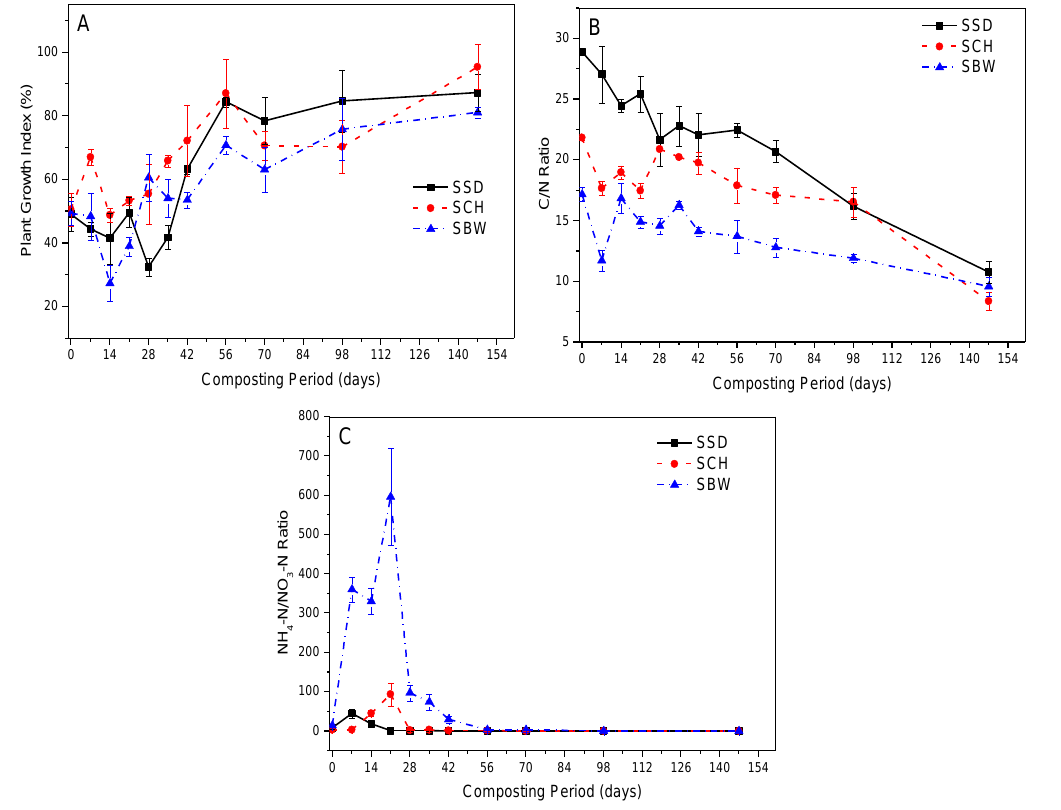
Figure 5. Changes in: ( A ) plant growth index; ( B ) carbon/nitrogen (C/N); and ( C ) ammonium-nitro- gen/nitrate (NH4 + -N/NO 3− -N) during composting of faecal sludge-FS with brewery waste-SBW, cof- fee husks-SCH, and sawdust-SSD. Error bars represent the standard error of n = 2. During the late stages of composting, all the composting piles exhibited a significant increase in the PGI values, which implied that the phytotoxic substance had disappeared, and the compost was generally phytotoxic free and mature. The literature has docu- mented the germination index/ plant growth index as one of the most reliable and sensi- tive indicators for evaluating compost phototoxicity and maturity [68]. PGI threshold value of ≥80% has been suggested for phytotoxic-free and mature compost [69]. In the present study, this threshold value was reached and exceeded after a composting period of 8 weeks by SSD and SCH piles. However, the compost was still immature at this stage since further fluctuations (drops) in PGI values below the threshold value were observed as the composting process progressed, until 14 and 21 weeks, respectively, when they sta- bilised. Similarly, the SBW composting piles reached the threshold value after a compost- ing period of 21 weeks and this implied that the compost was mature. It is very interesting to note that according to this PGI threshold value criterion, the SBW compost reached maturity after 21 weeks composting period, yet the composting temperature and other maturity indices had indicated that the SBW compost had stabilised or matured about 4 weeks earlier. This result suggests that there is no single index that can be used solely for accessing the efficiency of the composting process and compost maturity. However, the delay of the SBW piles in reaching the PGI threshold value can be attributed to the high NH 4+ -N concentrations observed in such piles, which may have inhibited plant growth. The PGI results also suggest that the bulking agent types had a significant effect (with p = 0.016) on the composting period of FS. The final PGI values of 81.0%–95.3% recorded in this study are in line with those published by other authors [68]. However, these PGI values are higher than the 60% GI